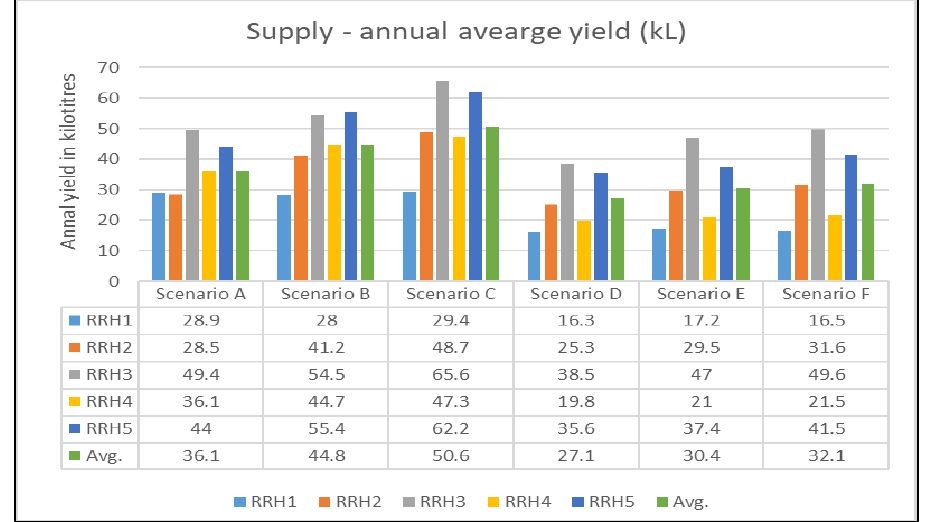
Figure 7. Comparison of RRHS modelling results: Annual yield.